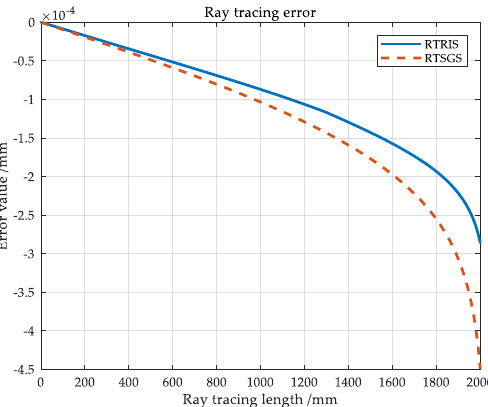
Figure 6. Ray tracing error example 2.